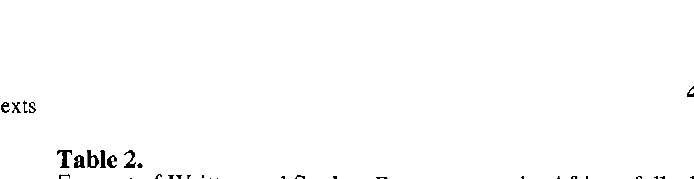
Excerpt of Written and Spoken Responses to the African folktale Part A: Written responses to the